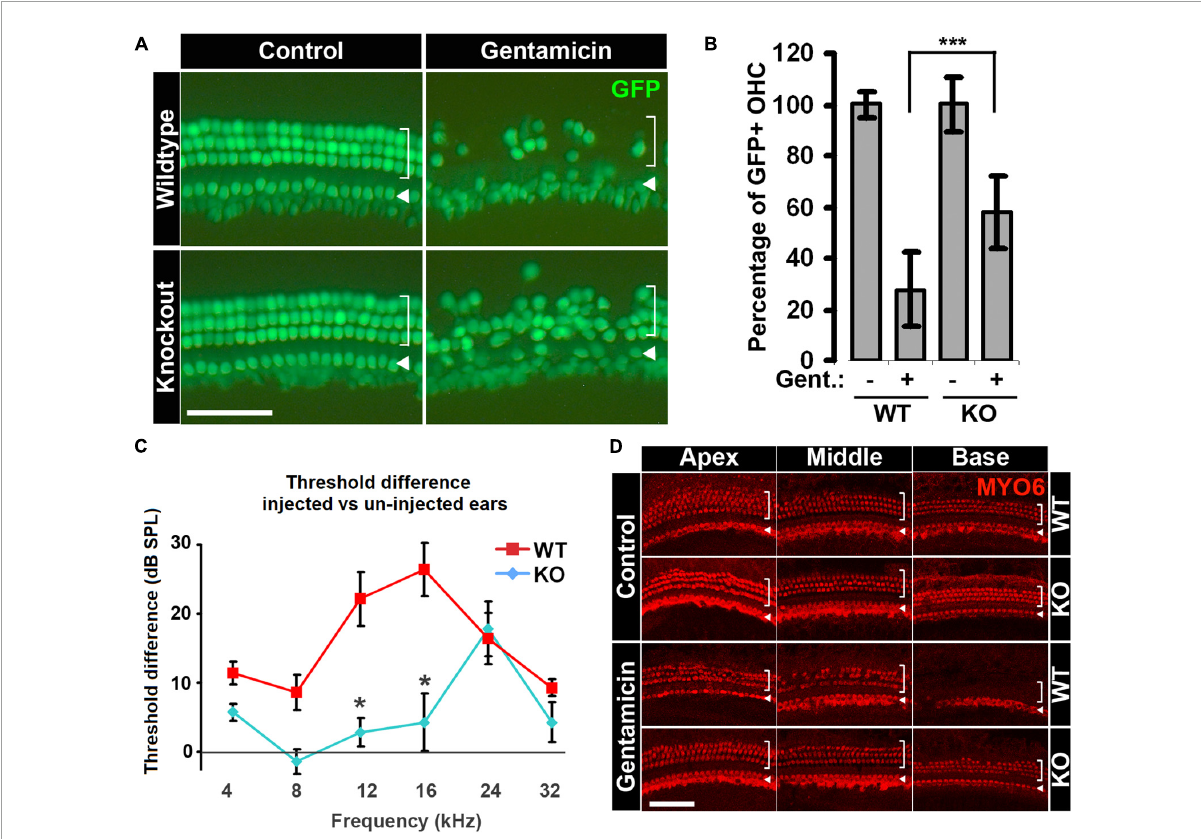
FIGURE4 Hair cells in Cdk2 –/– animals are less sensitive to gentamicin ototoxicity. (A) More hair cells survive gentamicin treatment in organotypic cultures of the organ of Corti from Cdk2 –/– animals. Representative images of the base of cochlea with or without gentamicin treatment are shown. Hair cells are not affected by Cdk2 deficiency in untreated control organs, and more hair cells survive gentamicin treatment in Cdk2 –/– organs. (B) Quantification of percentages of outer hair cells in Cdk2 +/+ and Cdk2 –/– organs with or without gentamicin treatment. For the comparison of gentamicin-treated organs between genotypes, p = 0.0008, n = 8. *** p < 0.01. (C) Gentamicin injection-induced ABR threshold shifts are smaller in Cdk2 –/– animals than Cdk2 +/+ littermates. The differences between two genotypes at 12 and 16 kHz are statistically significant with p = 0.0549 and p = 0.0538, respectively; n = 7. * p < 0.1. (D) Gentamicin injection induces milder hair cell loss in Cdk2 –/– animals compared to wild-type littermates, shown by immunostaining for MYO6. No difference is observed in untreated ears between genotypes (control panel), but hair cell loss is severe in Cdk2 +/+ animals in gentamicin-injected ears compared to Cdk2 –/– animals (gentamicin panel). Representative pictures of the apex, middle and base of cochleae are shown. For images of surface preps, inner hair cells are marked by arrowhead and outer hair cells are marked by bracket. Scale bars, 50 µ m. Error bars in panels (B,C) indicate standard